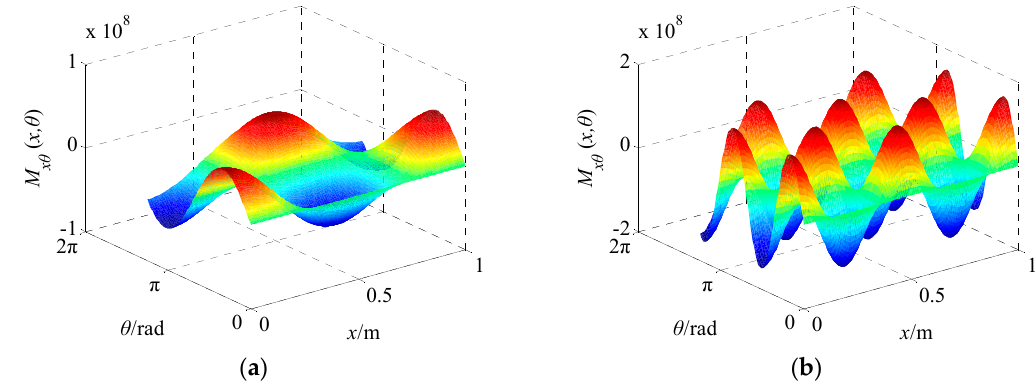
Figure 6. Shear modes of the UUV body structure with ( a ) B(2,1); ( b ) B(4,2).